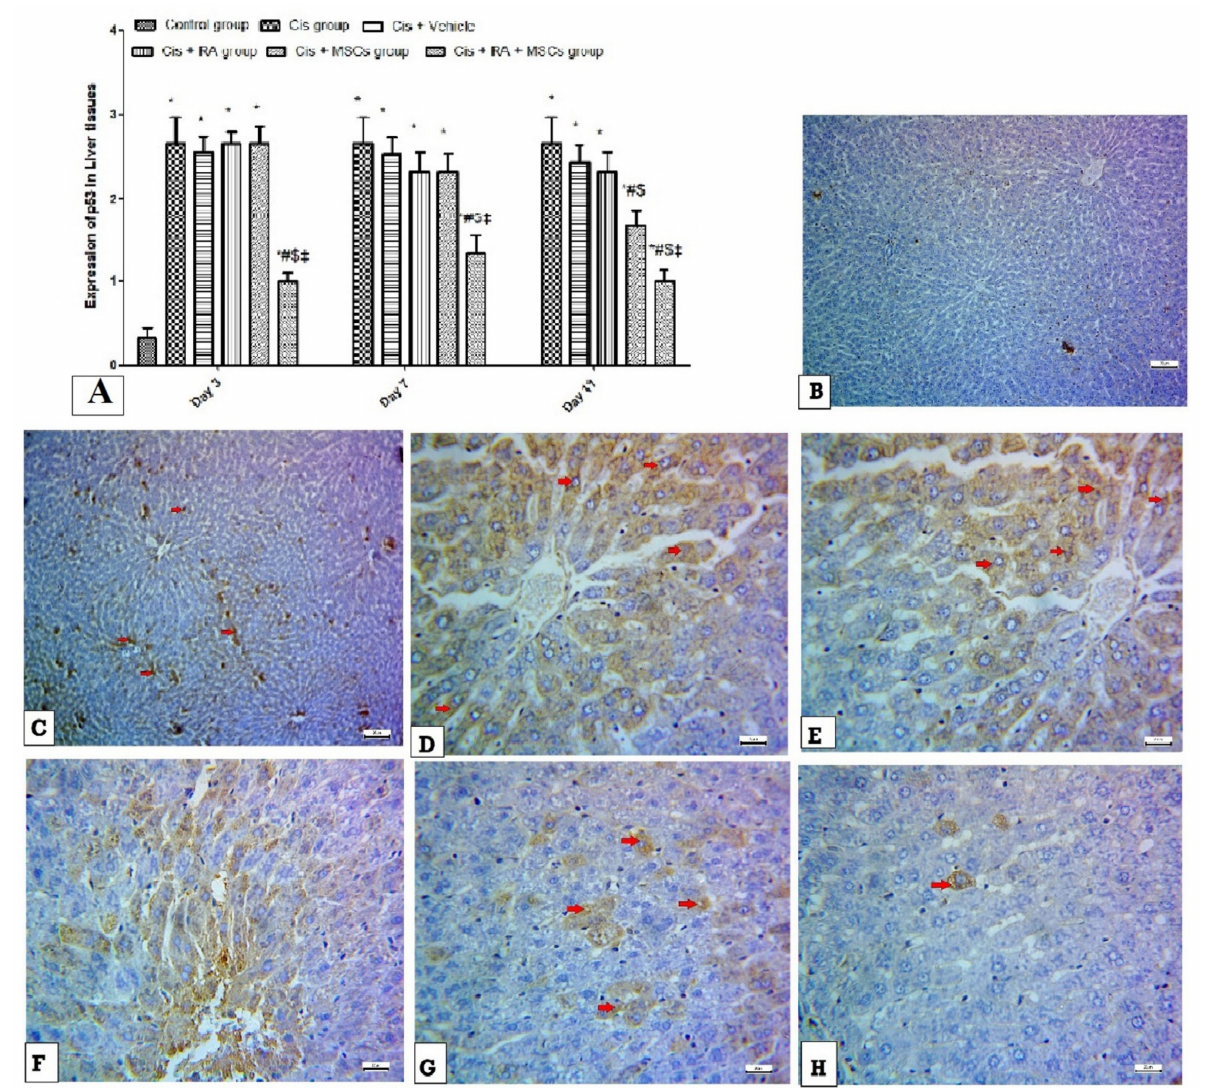
Figure 7. Immunohistopathological examination for the expression of p53 in liver specimens. The score of p53 expression in liver at different time intervals (3 days, 7 days and 11 days) showed significant rise in its expression in Cis group and significant attenuation in all treated groups (Cis + RA, Cis + BM-MSCs and Cis + RA + BM-MSCs groups) ( A ). Microscopic pictures of im- munostained hepatic sections against p53 from rats groups sacrificed at day 11 showing negative staining in control group (( B ) 100 × ), increased positive brown expression of p53 (red arrows) in hepatocytes in Cis group group at day 11 (( C ) 100 × and ( D ) 400 × ) and vehicle group ( E ) in contrast to treated groups where positive cytoplasmic brown expression (red arrows) in hepatocytes is moderate in group treated with RA group (( F ) 400 × ), MSCs group (( G ) 400 × ), to minimal expression in group treated with MSCs & RA group (( H ) 400 × ). * Significant vs. Control group, # significant vs. Cis group, $ significant vs. Cis + MSCs group and ‡ significant vs. RA